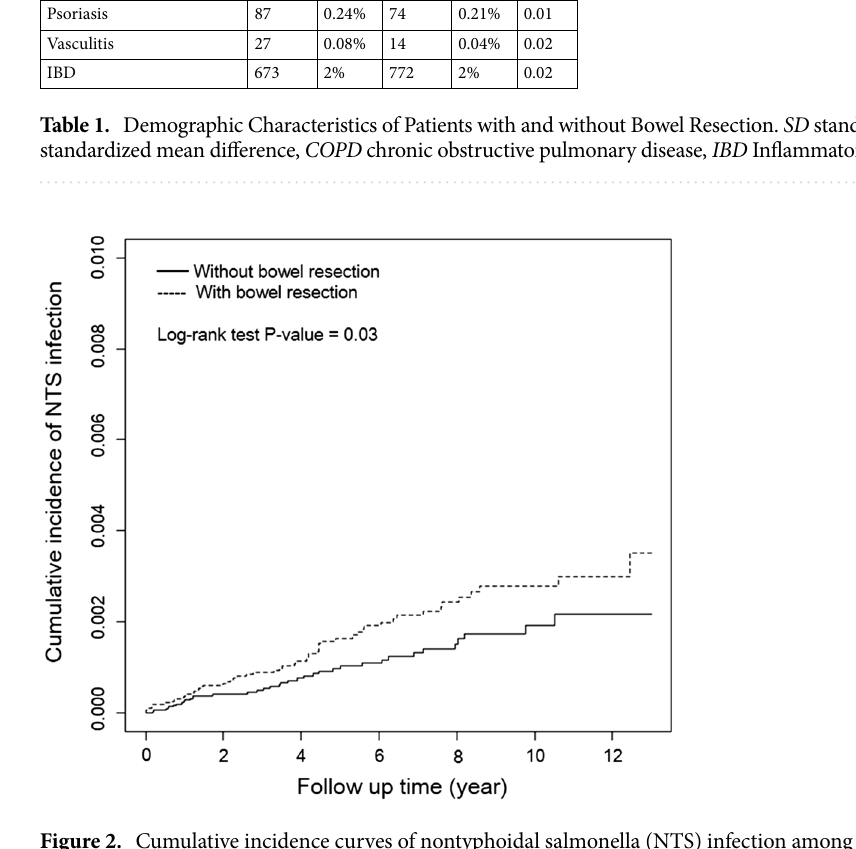
Figure 2. Cumulative incidence curves of nontyphoidal salmonella (NTS) infection among the propensity score–matched Cohort using The Kaplan–Meier